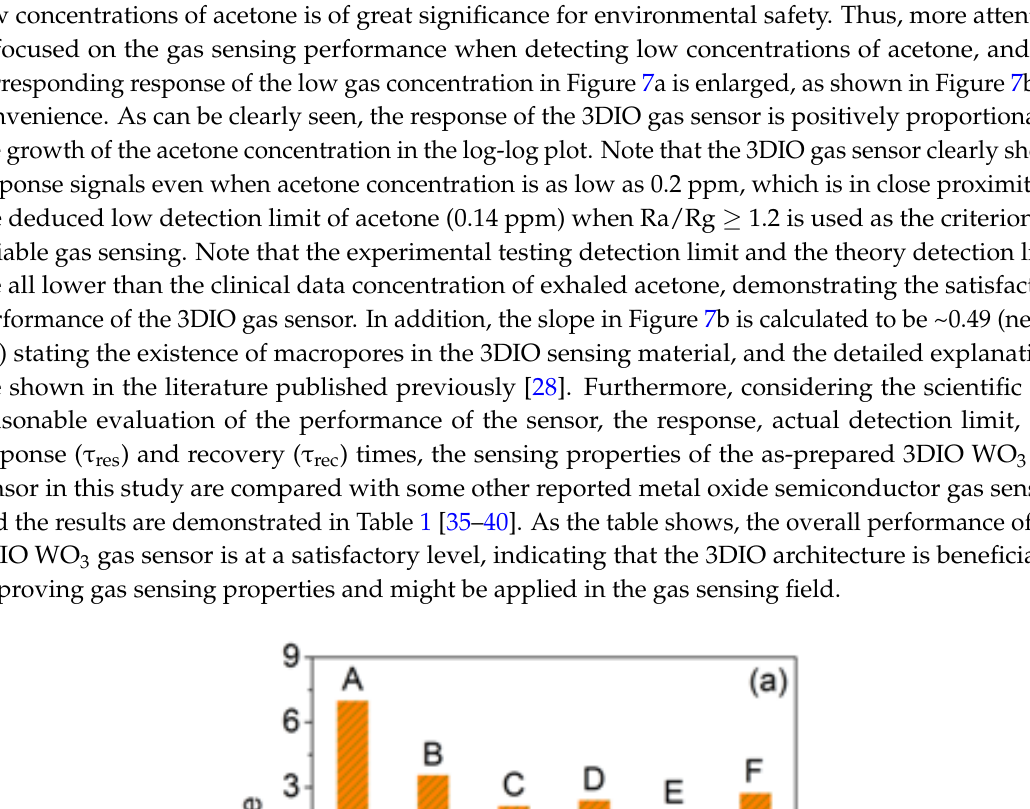
Figure 5. Relationship of responses vs. the operating temperature of the 3DIO WO 3 gas sensors to 5 ppm acetone. The lines are spline curves.